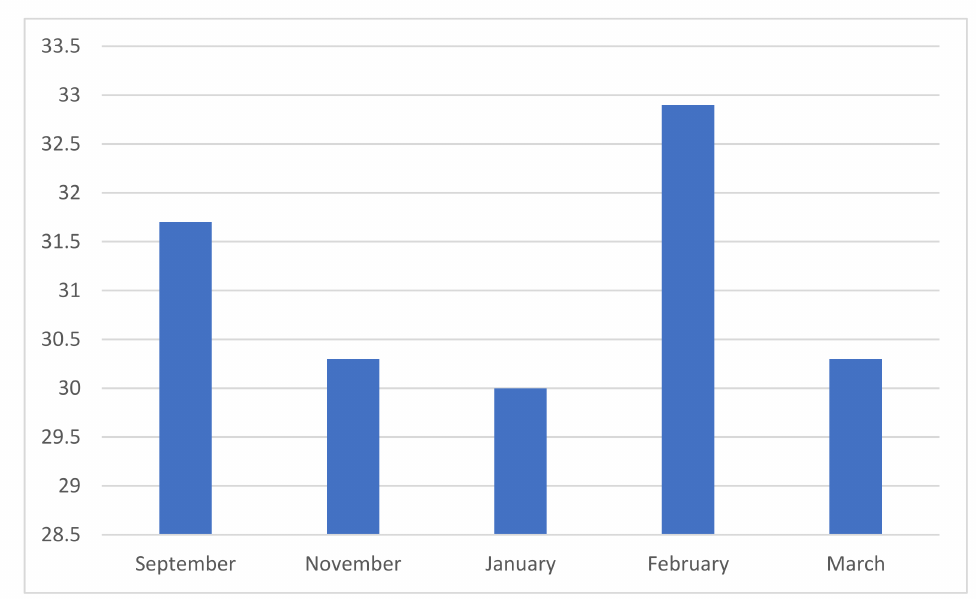
Figure 5. Accommodation and Enabling Scale ( n =